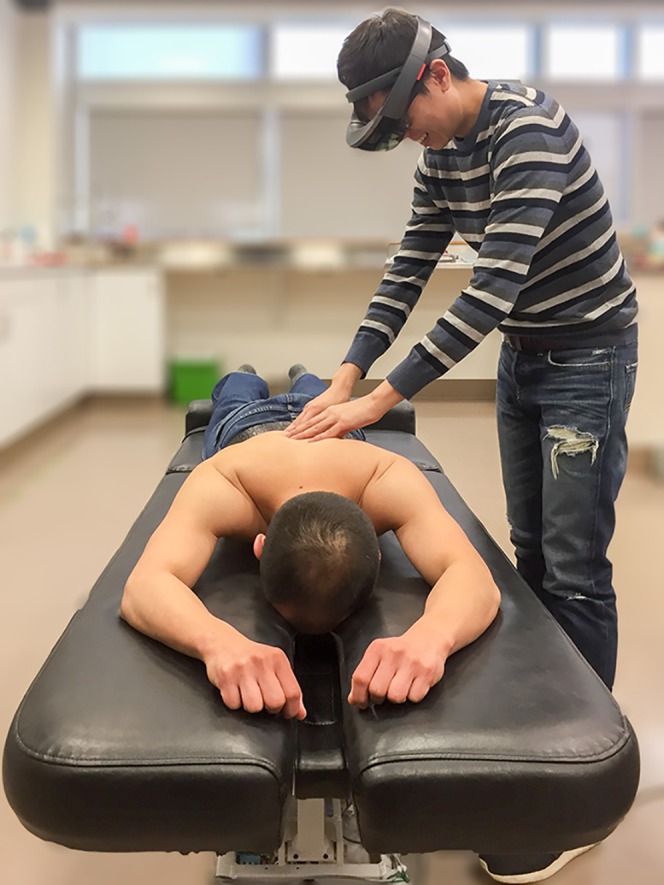
Use of HoloLens.